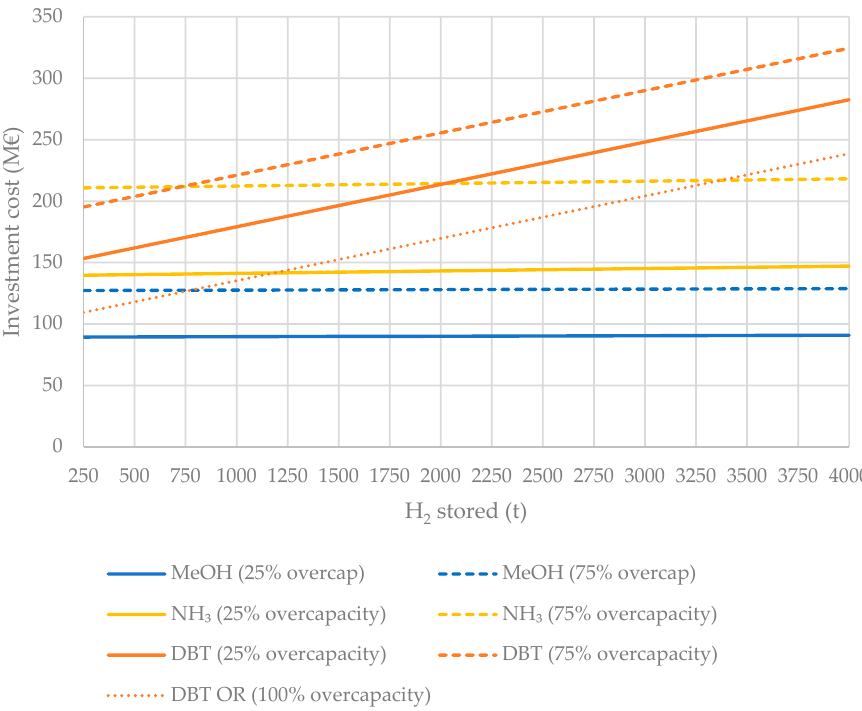
Figure 8. Total investment costs of liquid H 2 carrier-based H 2 storage systems (OR = one reactor concept).